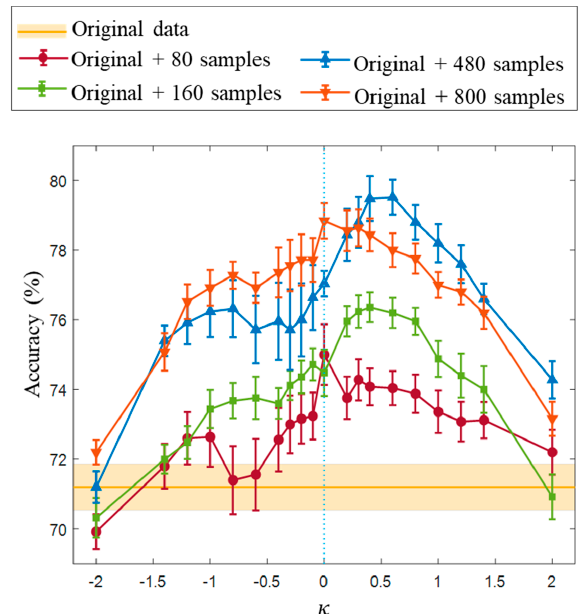
Figure 10. Classification accuracy when GNDv2 is used; the symbols and error bars represent the average accuracy and standard error, respectively.